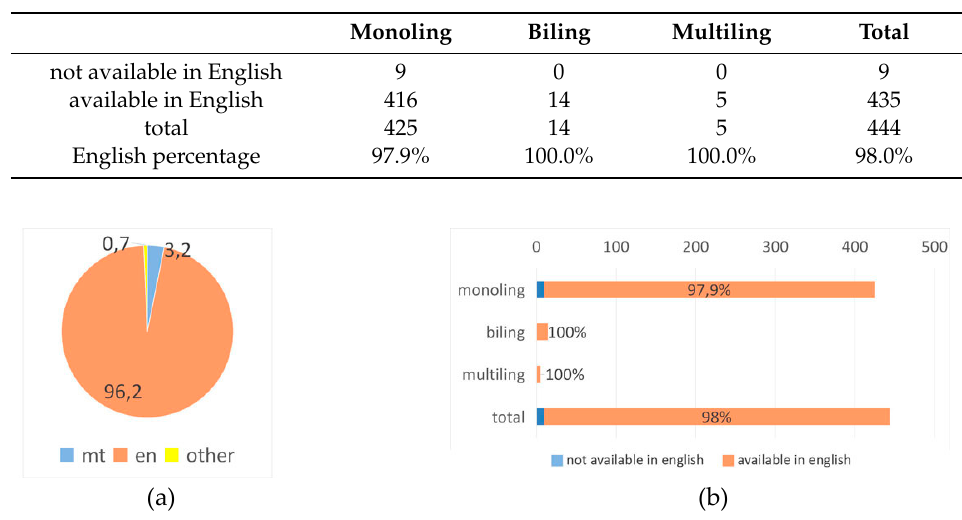
Figure A19. Visualization of the results for domain mt. ( a ) Primary languages pie chart and ( b ) English language availability bar chart.